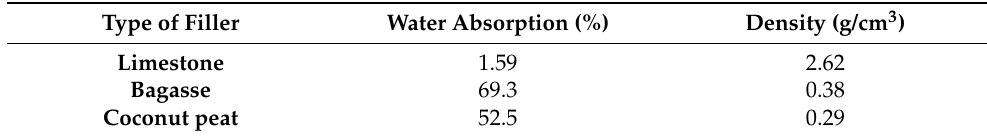
Table 2. Moisture absorption and density for different fillers.